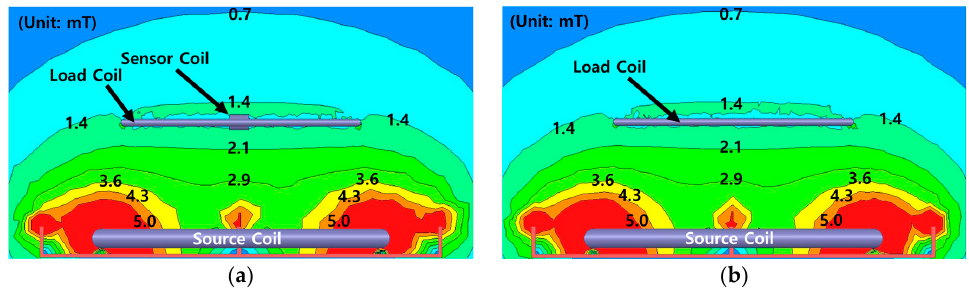
Figure 11. Simulation results showing the magnetic flux density for the load coil ( a ) with the sensor coil unit and ( b ) without the sensor coil unit.